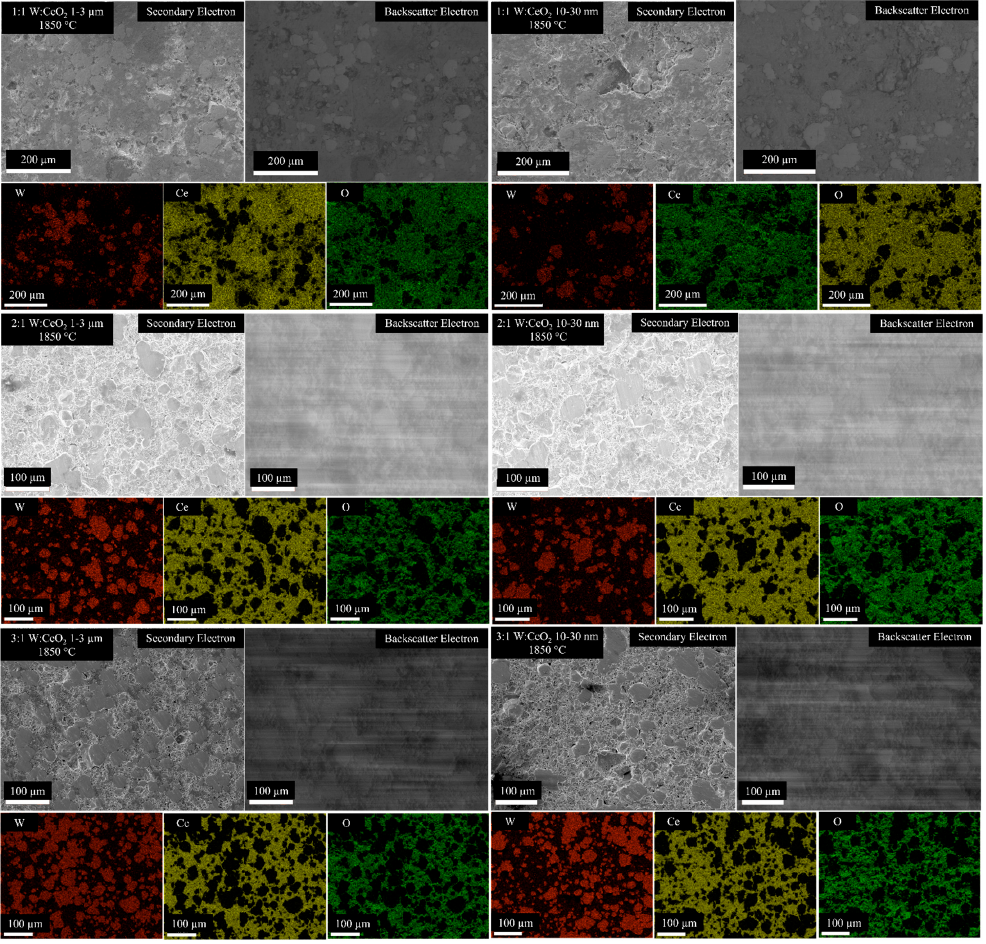
Figure 4. SEM micrographs and SEM-EDS compositional maps of W, Ce, and O of the several W:Ce composites processed by the conditions labeled.